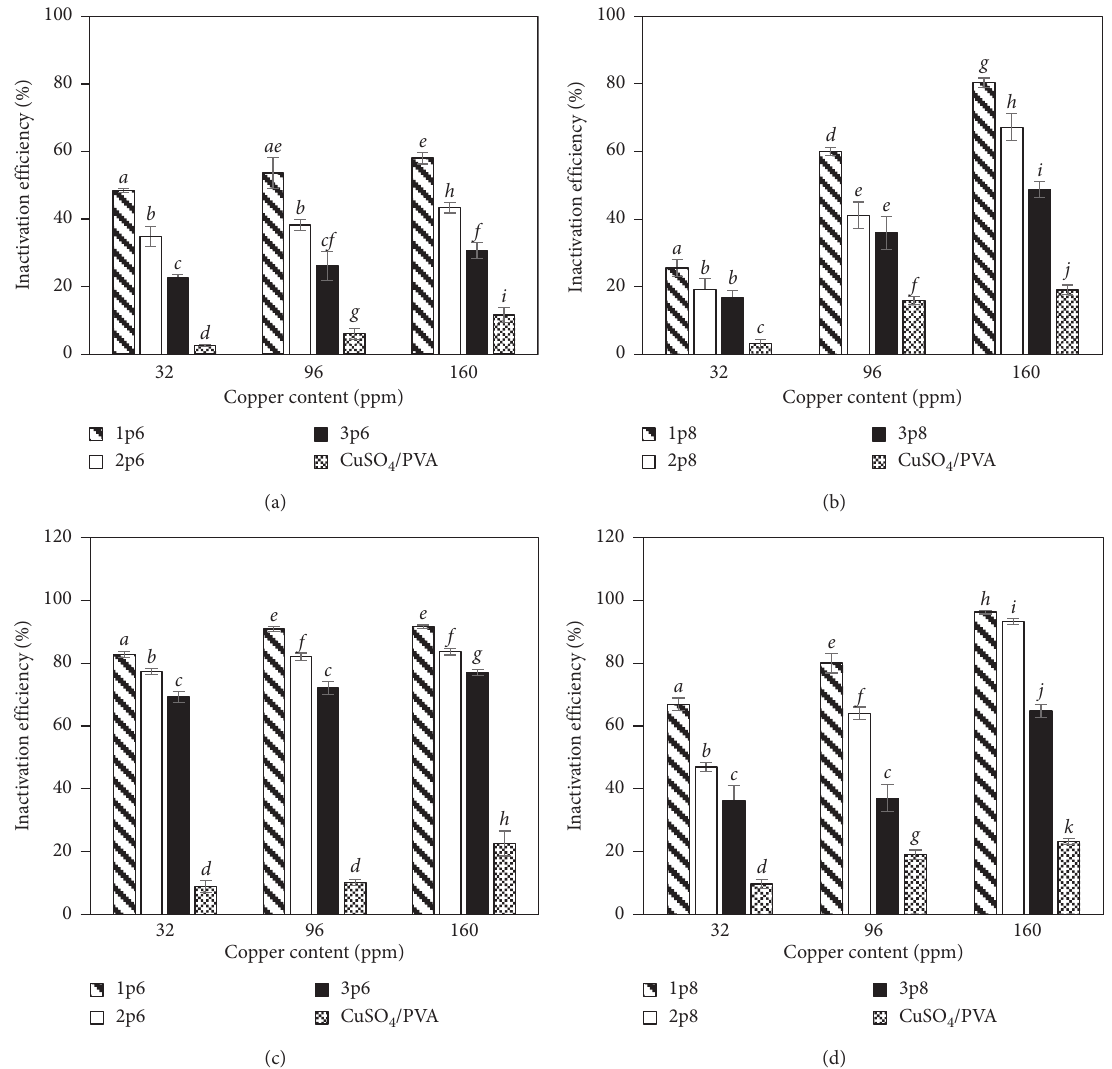
Figure 4: Inactivation efficiencies of Cu 2 O NP incubated at pH 6 and pH 8 after 1h and 24h of contact with E. coli suspension ((a) pH6, 1h; (b) pH8, 1h; (c) pH6, 24h; (d) pH8, 24h). Different letters on the bars in the graph demonstrate significantly different inactivation efficiencies ( p < 0 .